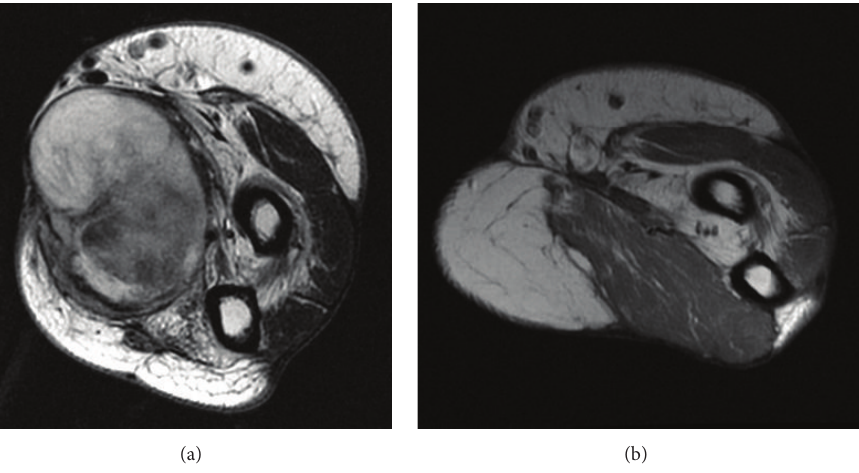
Figure 1: Preoperative T2 axial MRI image showing a heterogenous, subfascial mass (a) compared with postoperative T1 axial MRI image showing no evidence of residual mass